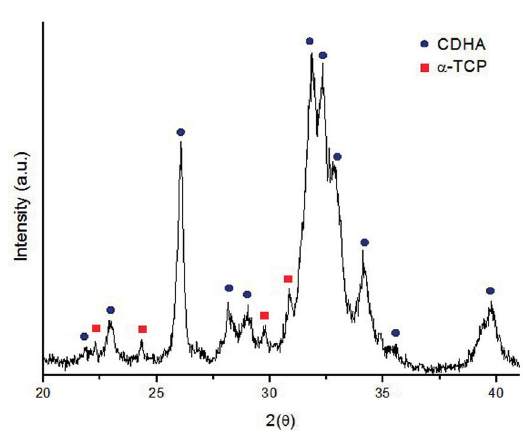
Figure 5: XRD pattern for an α-TCP cement sample prepared with L5